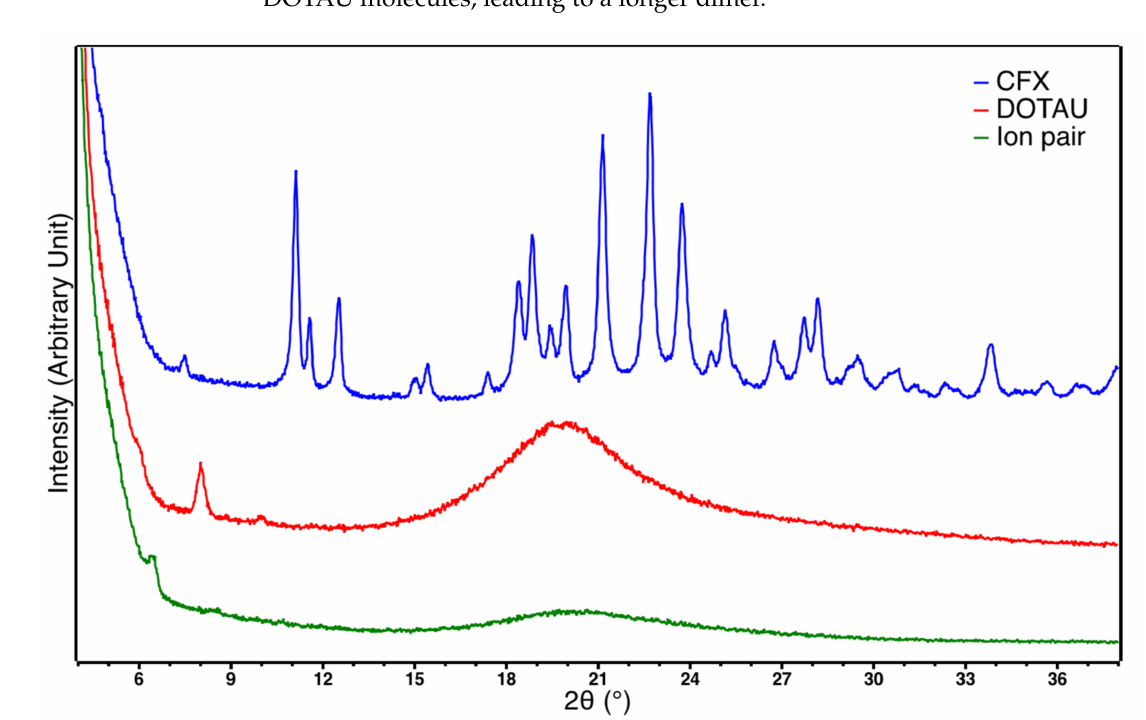
Figure 2. X-ray diffractogram of CFX (blue), DOTAU (red) and ion pair (green).